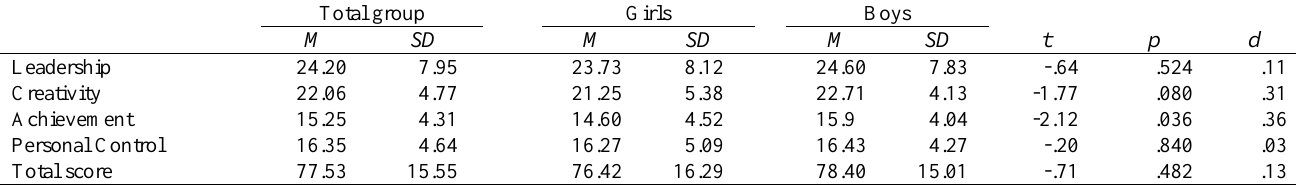
Table 1: ATE test factors’ means and standard deviations, and gender differences in Study 1 Total group